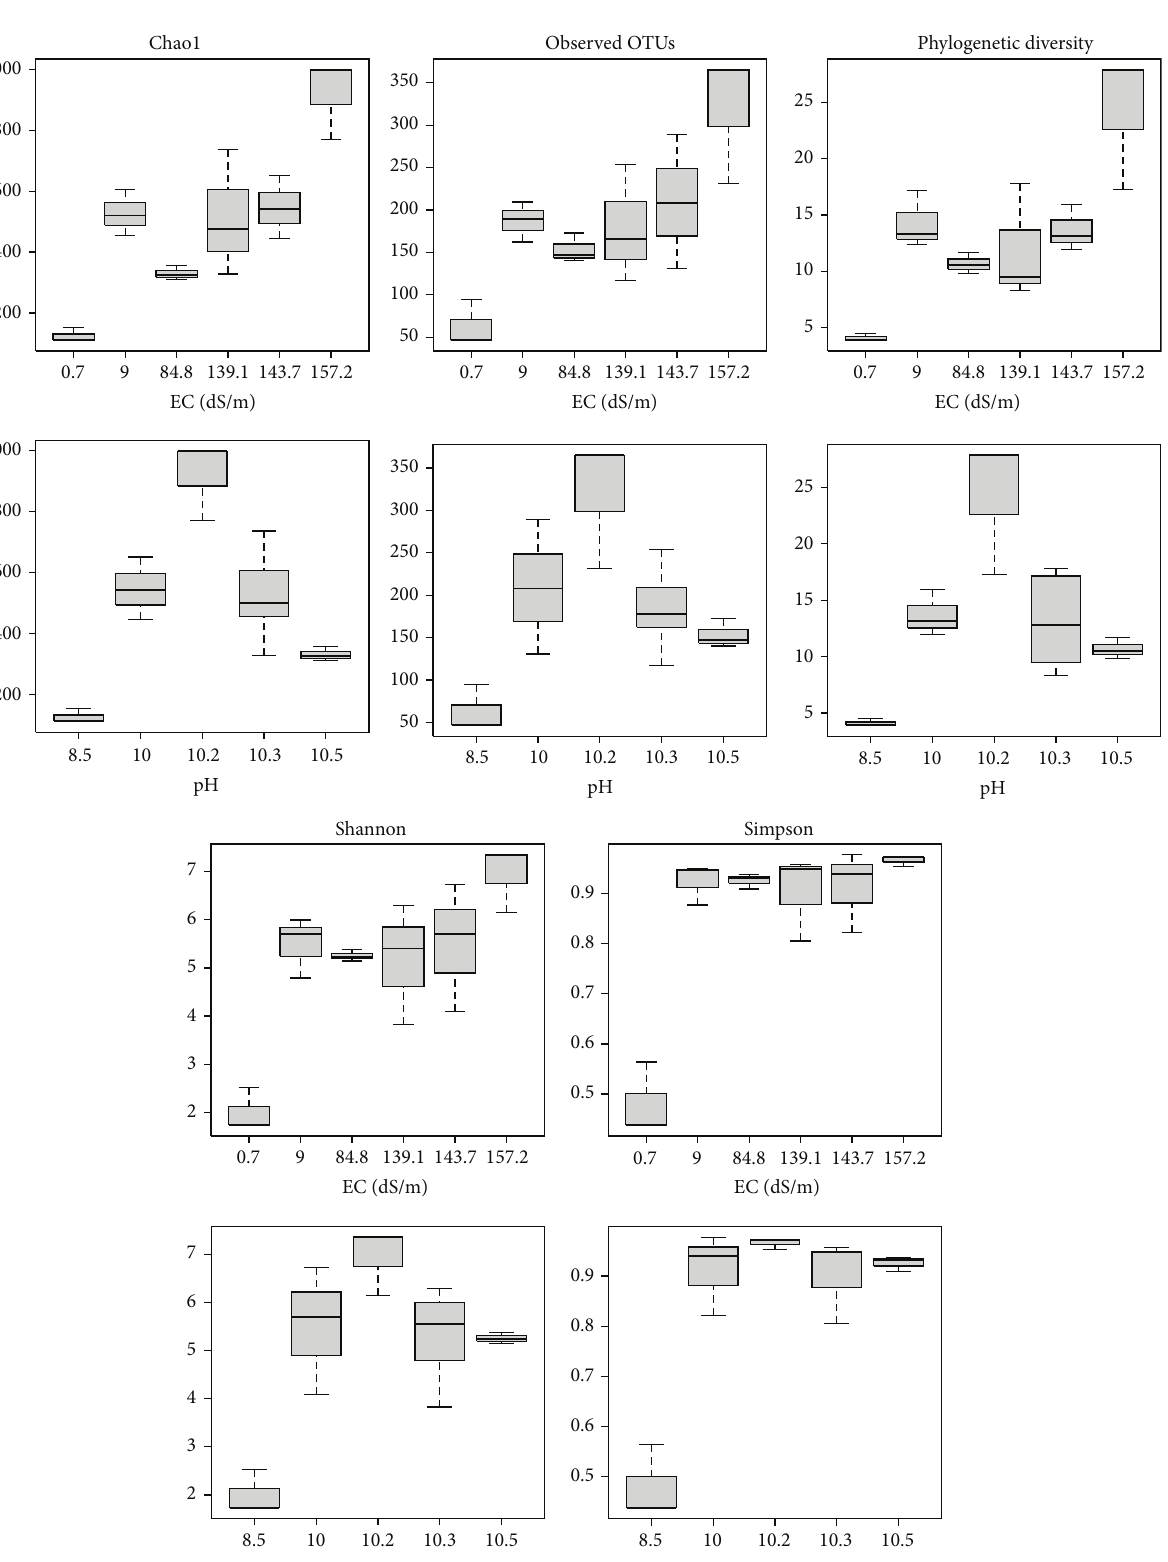
Figure 1: Boxplots of the alpha diversity parameters of the archaeal communities in alkaline-saline soils of the former lake Texcoco with different electrolytic conductivity and